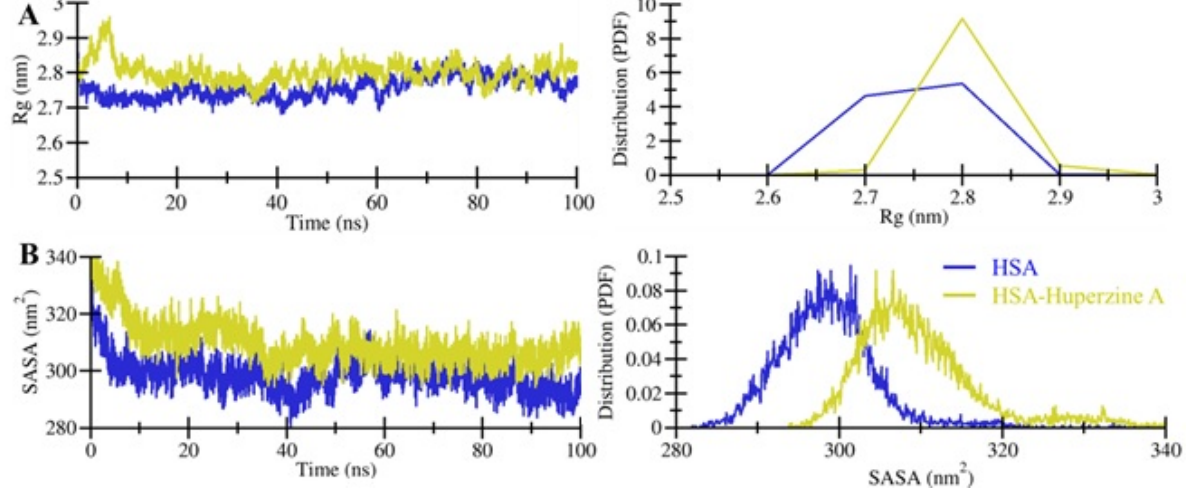
Figure 4. Structural compactness of HSA as a function of time. ( A ) Time evolution of the radius of gyration. ( B ) SASA plot of HSA as a function of time.